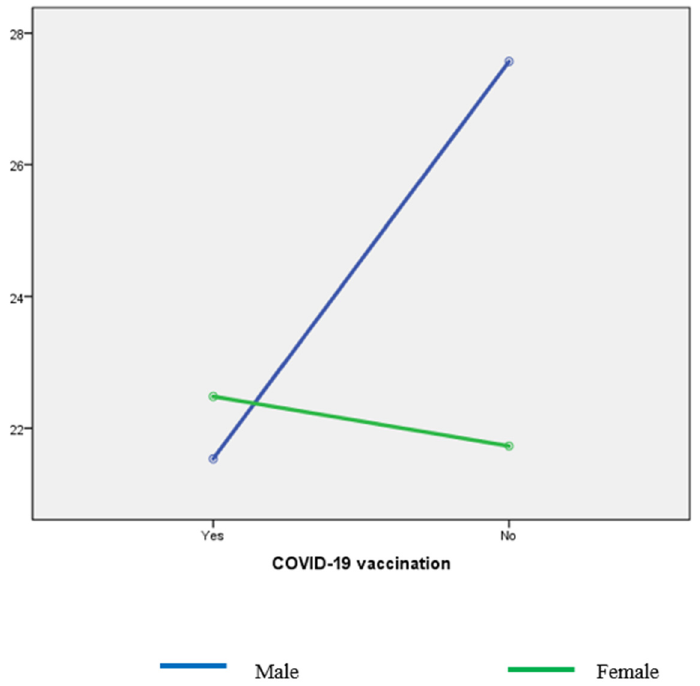
Figure 1. Fear of COVID-19 by gender and COVID-19 vaccination status. The mean BRS (resilience) scores were 19.5 (SD = 2.8) and 18.8 (SD = 2.6) for the male and female students, respectively (t(431) = 2.401; p = 0.017). The average resilience value for all students was 19.2 (SD = 2.8). Two-way ANOVA showed that resilience scores were associated with gender and COVID-19 vaccination: F(1,429) = 4.671; p = 0.031 (Figure